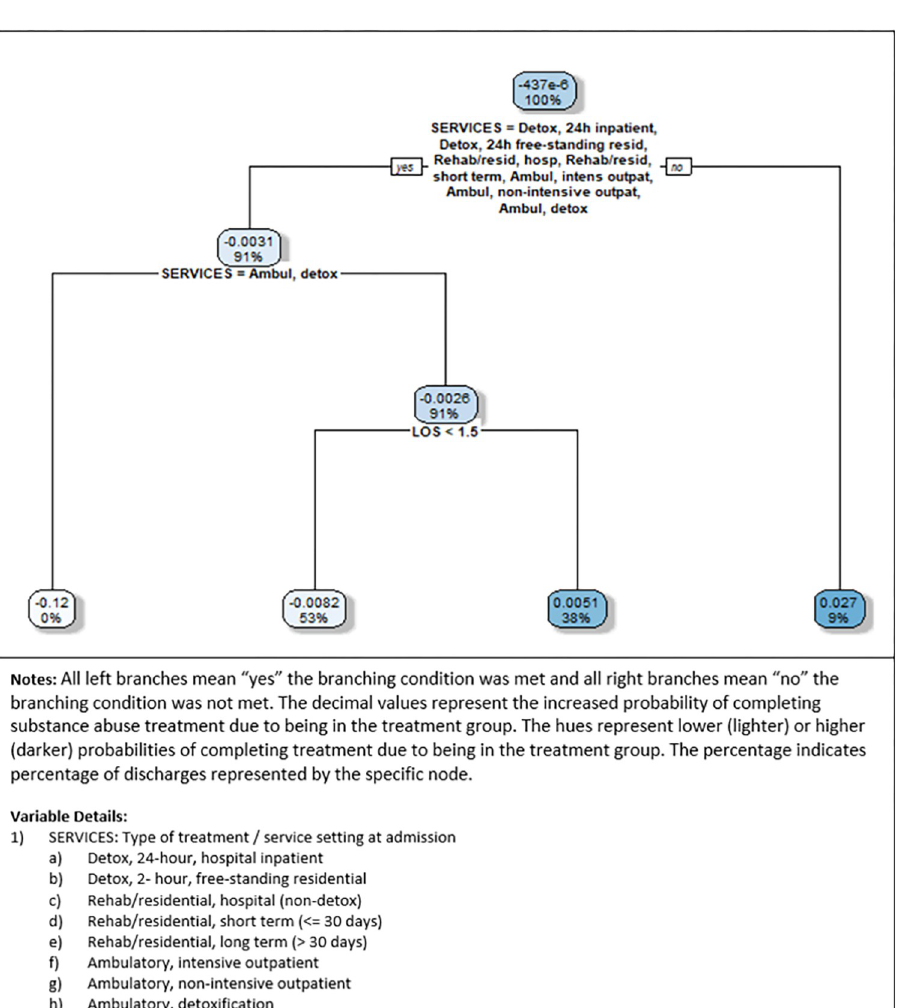
Fig 2. Race/ethnicity decision tree (P 1i = white